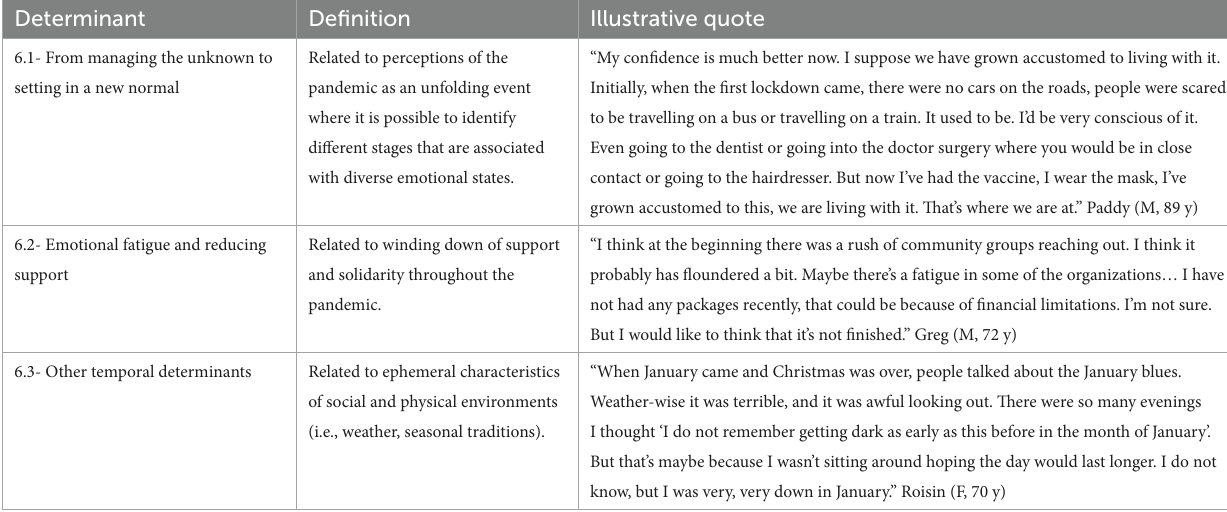
TABLE 7 Detailed socio-ecological determinants at the chrono-system